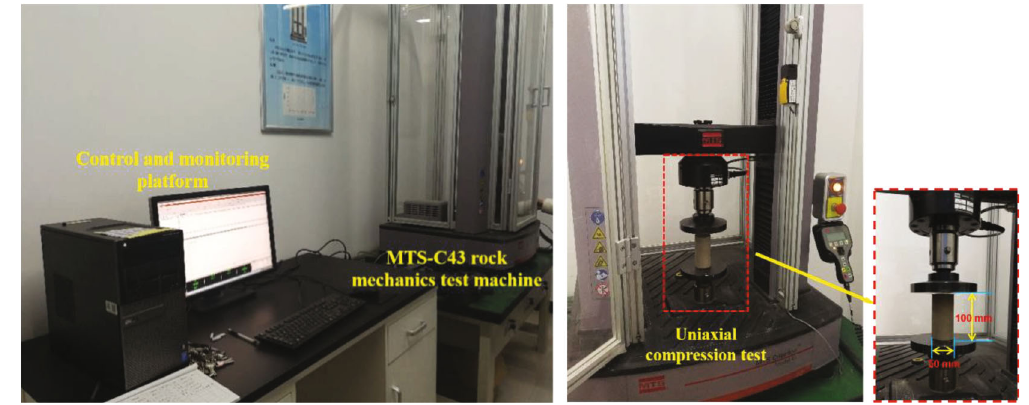
Figure 3: Experimental